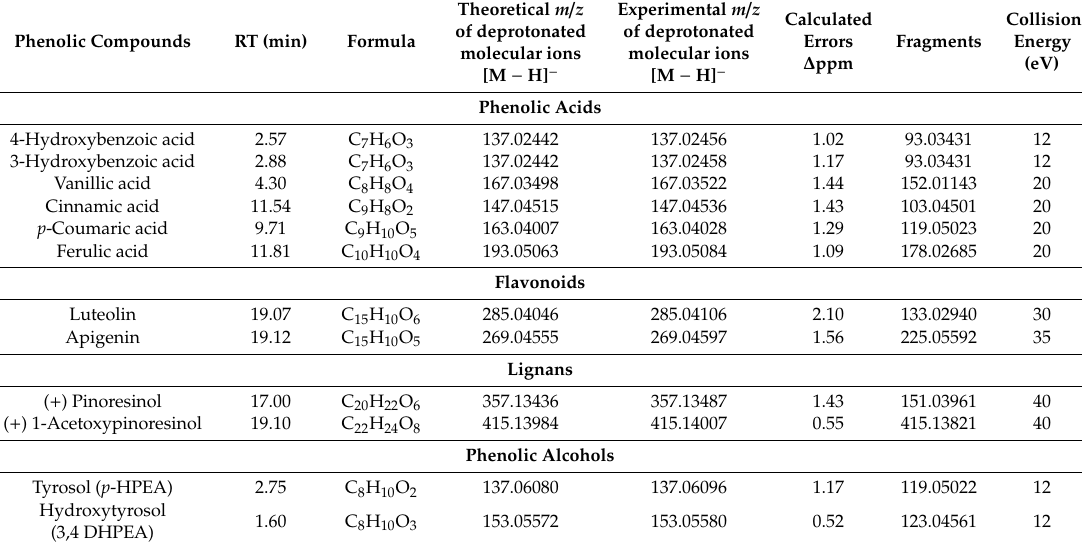
Table 2. Phenolics’ identification